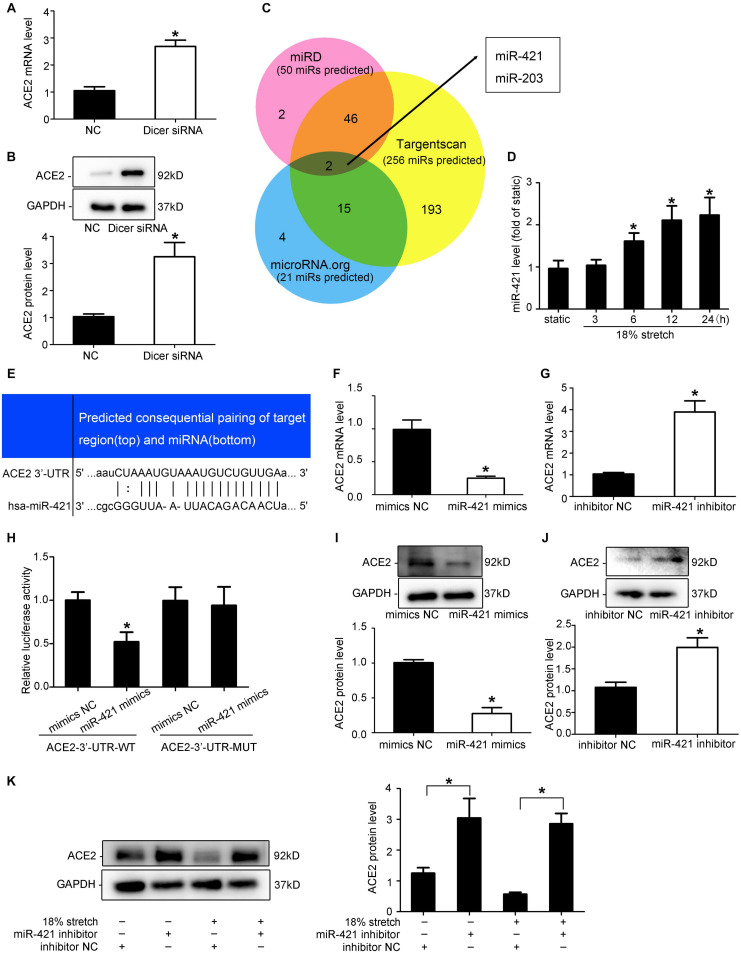
miR-421 is involved in the expression of ACE2 under mechanical stretch. (A,B) RT-qPCR and Western blot analysis of ACE2 mRNA and protein expression in vascular smooth muscle cells (VSMCs) transfected with Dicer siRNA. (C) Venn diagram of the number of transcription factors in three libraries. (D) RT-qPCR analysis of the levels of miR-421 under 18% mechanical stretch for the indicated time. (E) Sequence alignment between miR-421 and putative binding sites in the 3′-UTR of ACE2 mRNA. (H) Effects of the miR-421 mimics on the activities of the luciferase reporter plasmids with the full-length (Wild) and mutated (Mut) ACE2-3′-UTR. HEK-293T cells were transfected with the ACE2-3′-UTR-WT and ACE2-3′-UTR-mut, together with miR-421 mimics, for 48 h. (F,G,I,J) RT-qPCR and Western blot analysis of ACE2 mRNA and protein expression in VSMCs transfected with miR-421 mimics (or inhibitor). (K) Western blot analysis of ACE2 protein expression in VSMCs under stretch for 12 h transfected with miR-421 inhibitor. Values are expressed as means ± SEM. *P < 0.05 vs. NC group (n = 4).